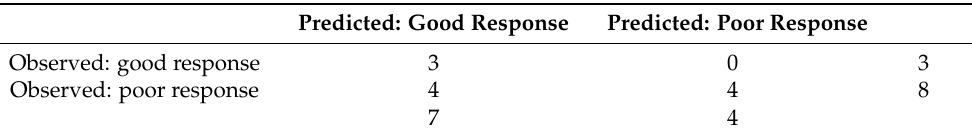
Table 4. Confusion matrix showing the combined radiomic-clinical model performance in the testing